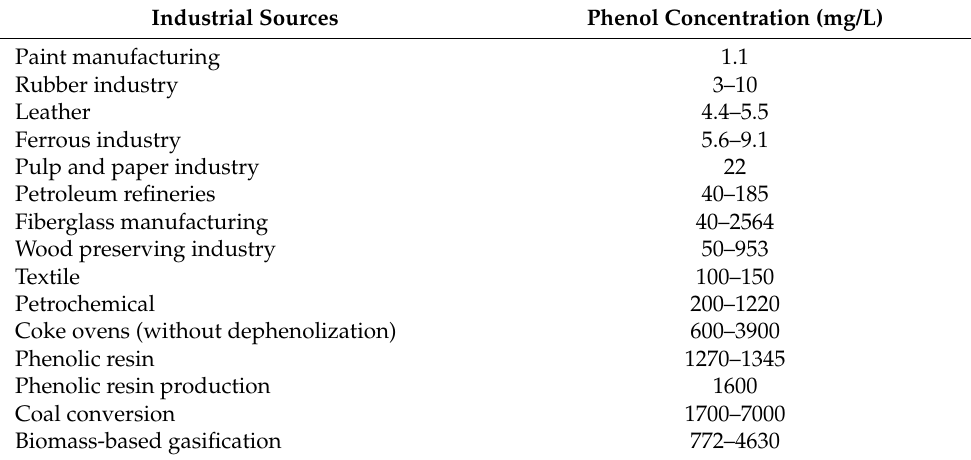
Table 1. The reported levels of phenol in industrial wastewater. Adapted from ref. [9]. Copyright 2006